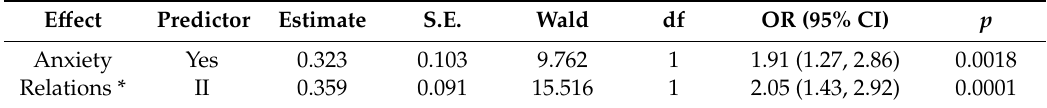
Table 15. Prediction of sleep bruxism (SB) in Israel.